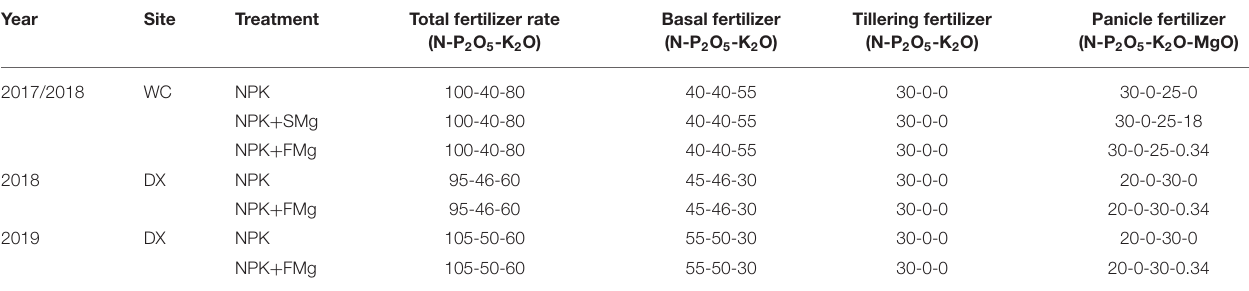
TABLE 2 | Timing and amounts of applied fertilizer (kg hm − 2